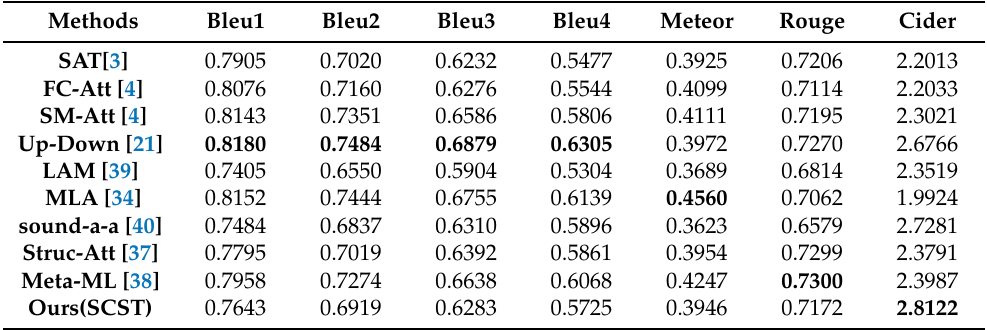
Table 1. Comparison of scores for our method and other state-of-the-art methods on the Sydney- Captions data set [33].